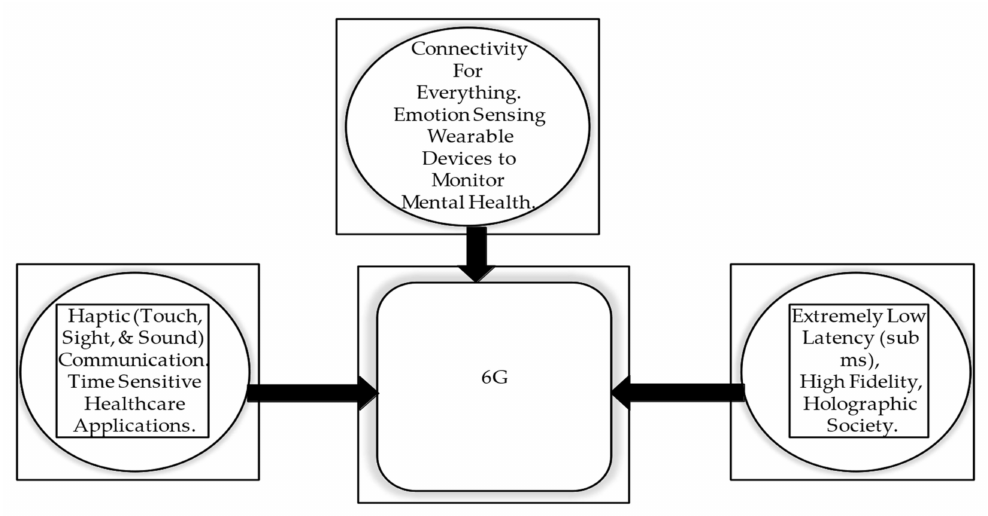
Figure 1. Examples of 6G for healthcare